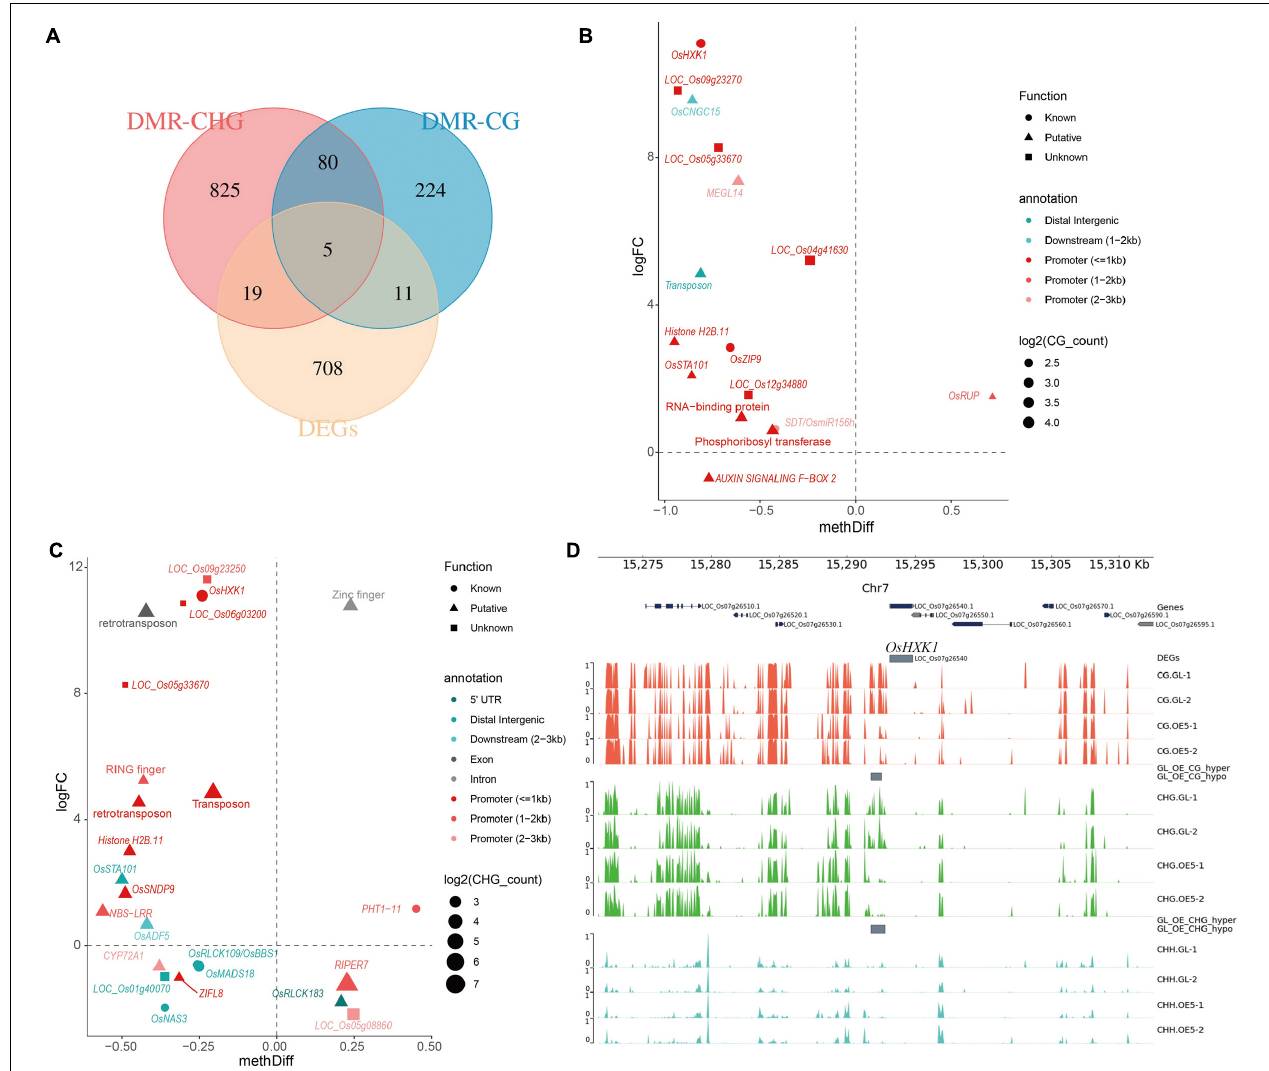
FIGURE 5 | Overlap analysis between DMGs and DEGs. (A) The distribution of overlapping genes between DMGs and DEGs. Scatter plots of the correlation between methylation difference and expression fold change for overlapping genes in CG (B) and CHG (C) contexts. (D) Visualization of methylation status for the representative gene OsHXK1